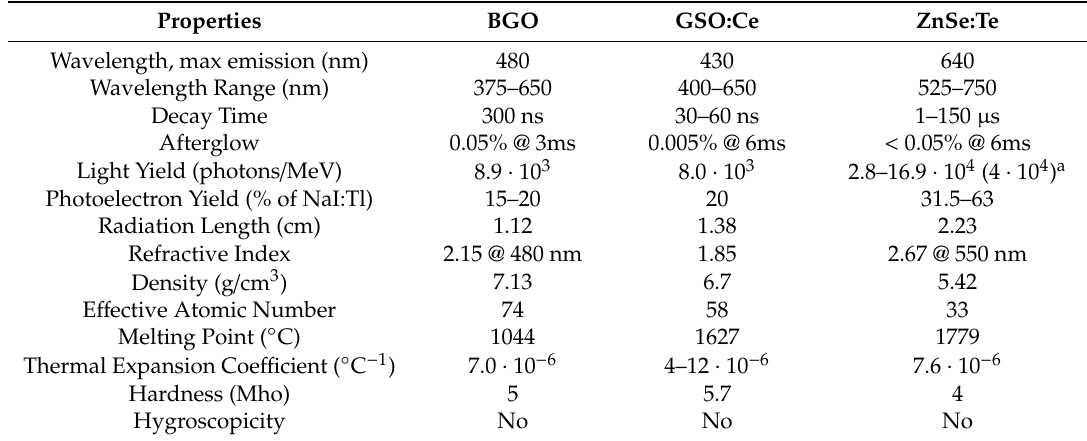
Table 1. BGO, GSO:Ce, ZnSe:Te crystal properties